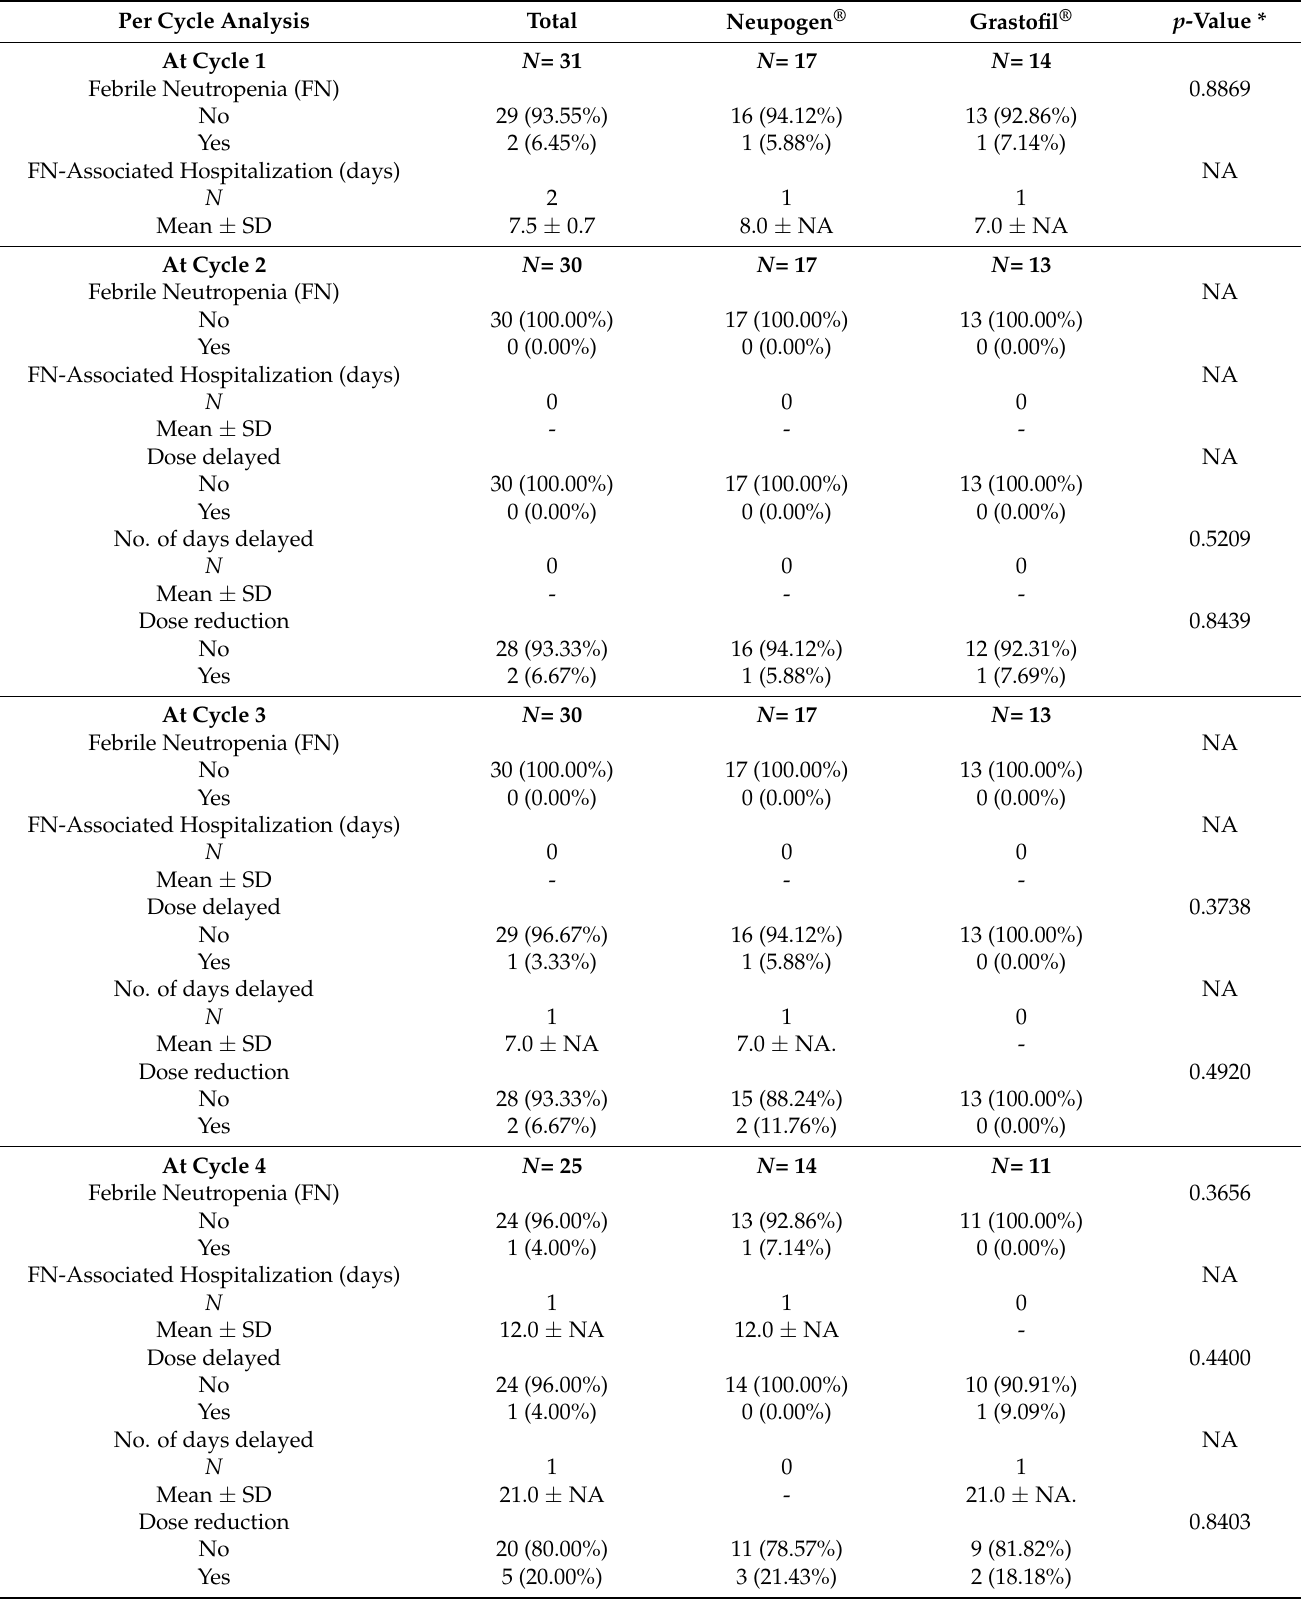
Table A2. Cycle-per-Cycle Outcomes in Lymphoma Cancer